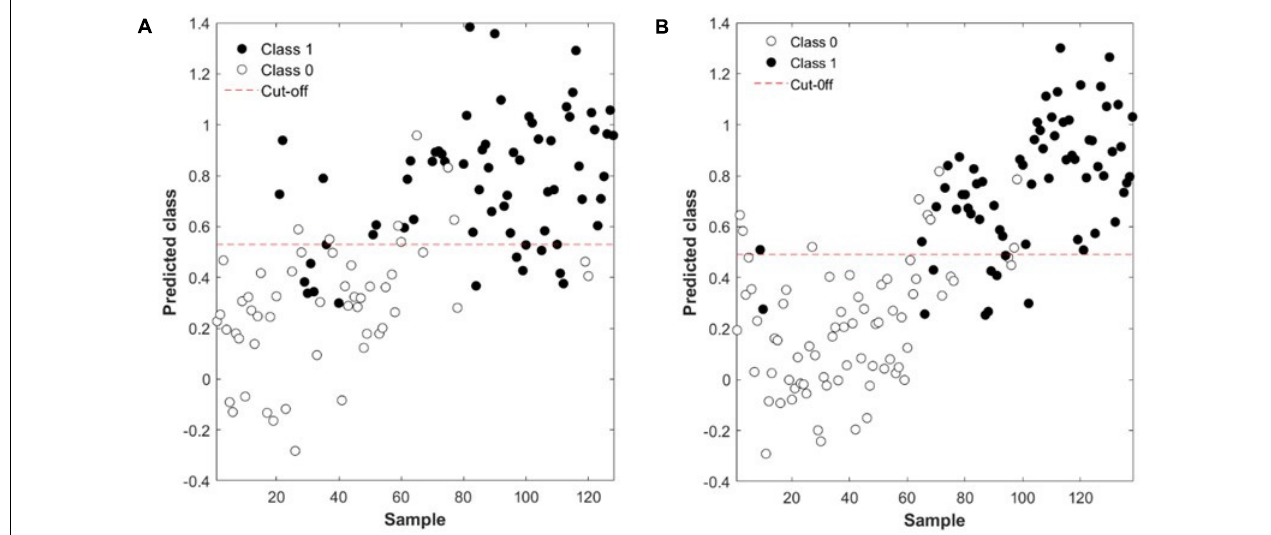
FIGURE 2 | Absence (Class 0, open circle) or presence (Class 1, close circle) of chocolate browning in ‘Regal Seedless’ table grape bunches performed by a partial least squares discriminant analysis (PLS-DA) model, based on near-infrared (NIR) spectral data. (A) Weeks 3 and 4 and (B) Weeks 5 and 6.